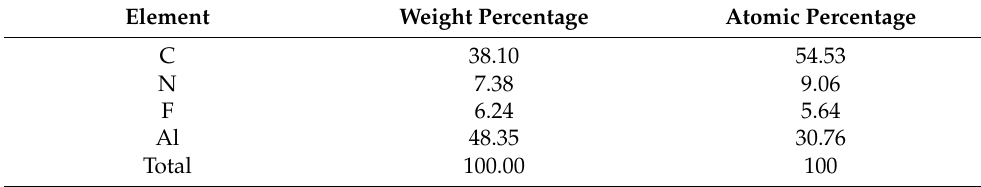
Figure 4. SEM image and EDS spectra of explosive 1. Table 3. Elemental weight and atomic percentage of explosive